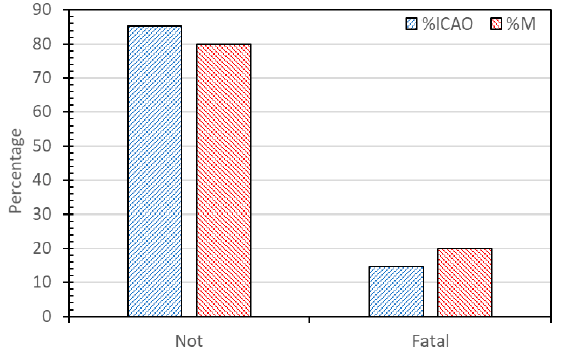
Figure 1. Distribution of fatalness for accidents with maintenance contributions.